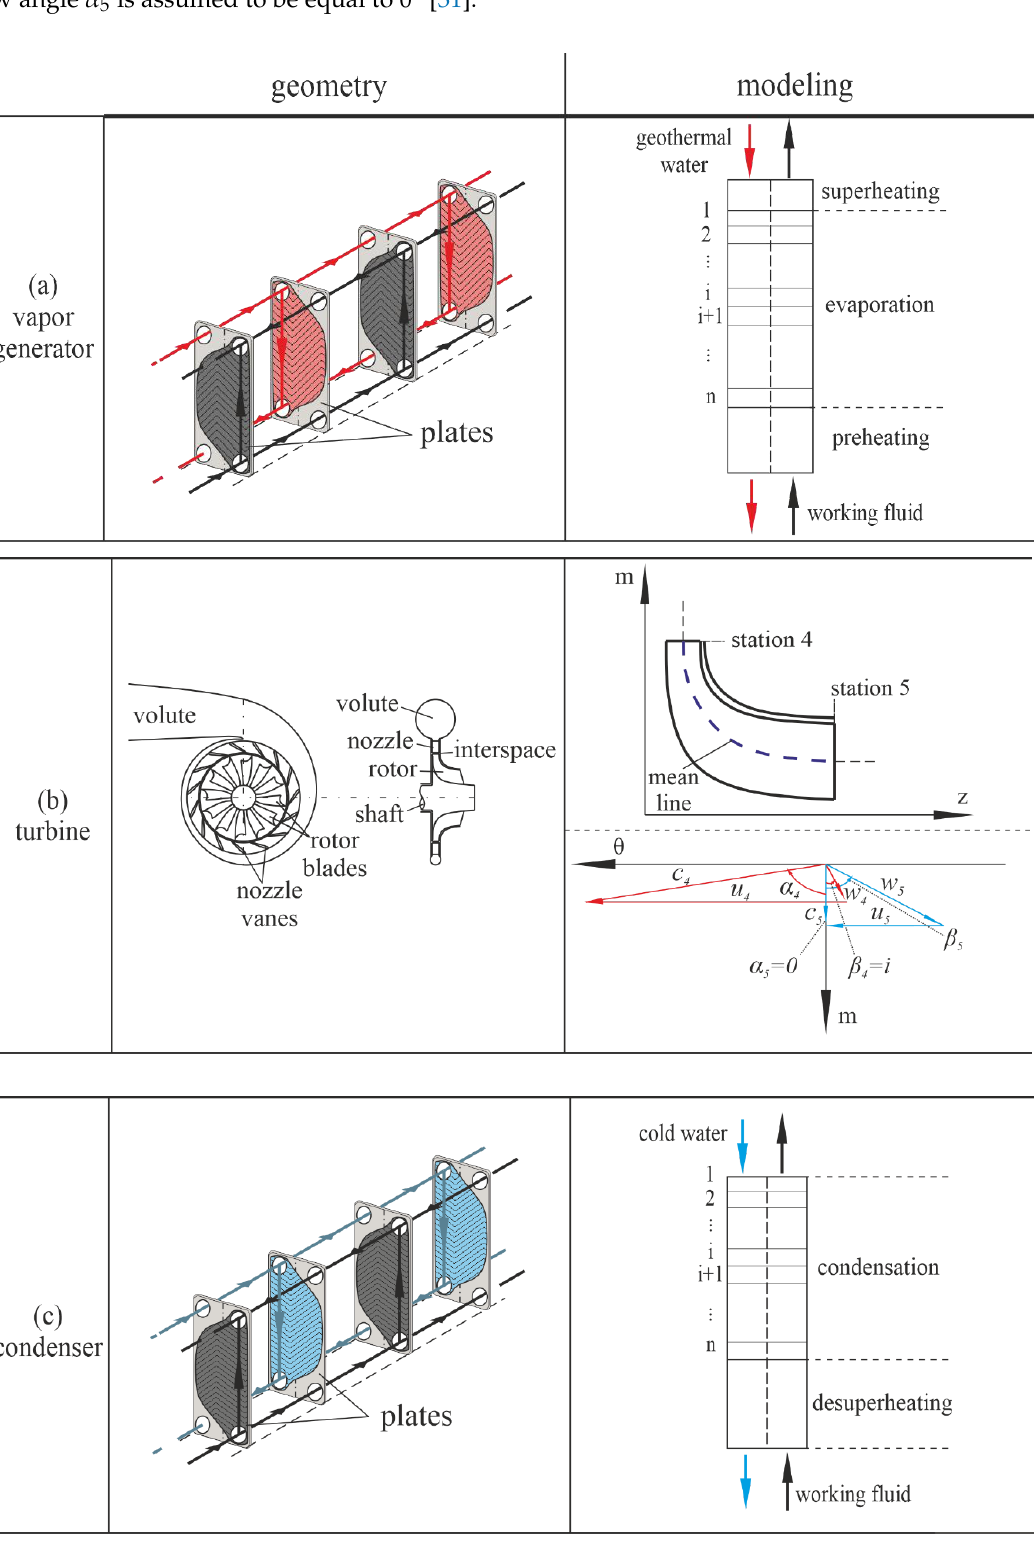
Figure 2. Geometry and modeling of system components: ( a )—vapor generator, ( b )—turbine, ( c )—condenser [26].